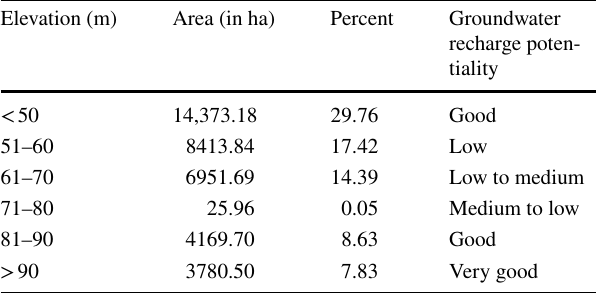
Table 3 Vegetation characteristics and their areal extent of